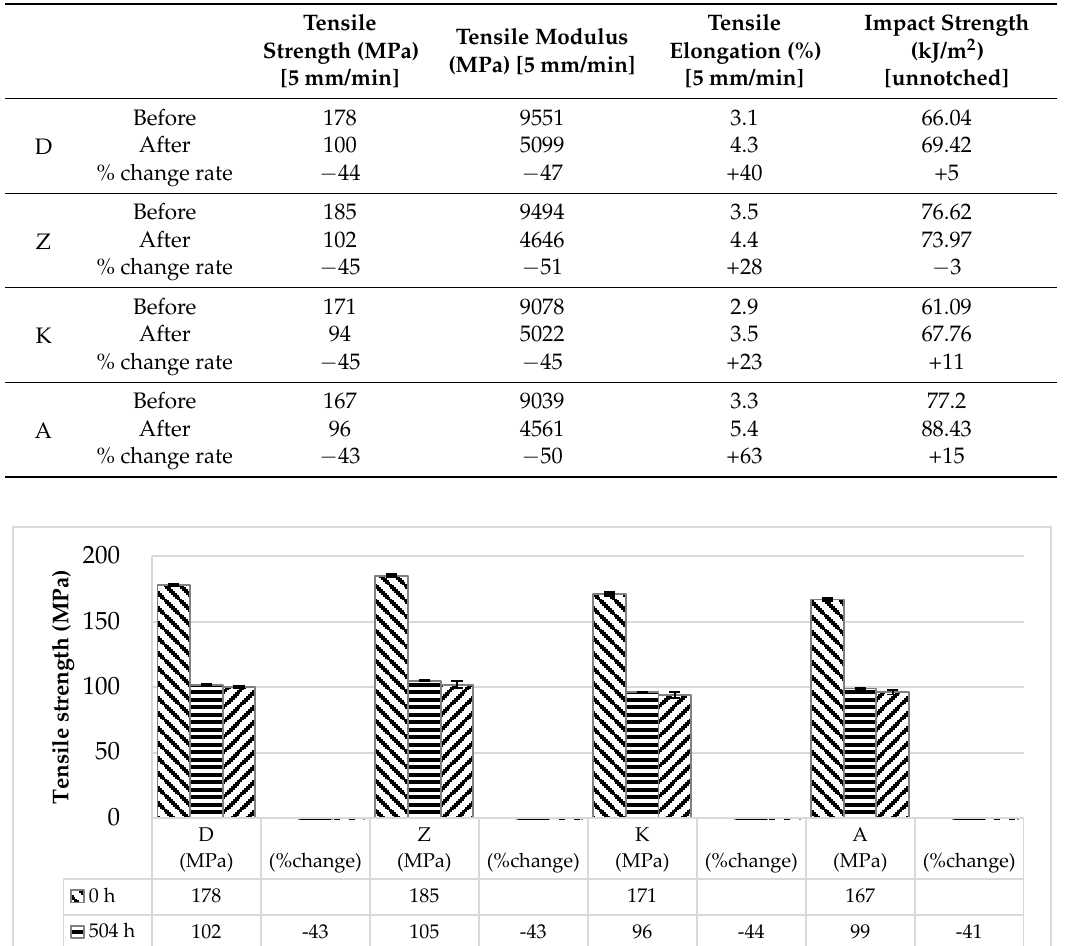
Table 2. Mechanical properties of various glass fiber-filled polyamide66 composites, before and after immersion in monoethylene glycol (MEG) (1,008 h) at 130 °C.